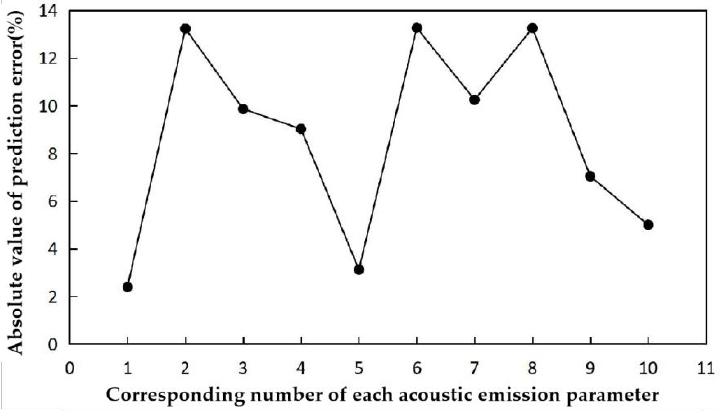
Figure 16. Prediction error of each single-parameter neural network.